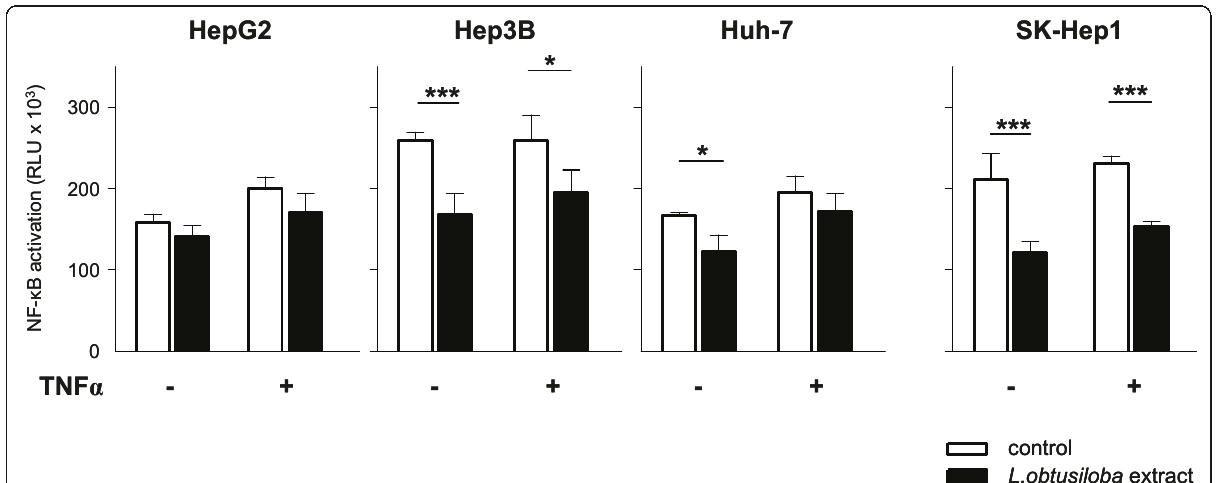
Figure 3 NF- (cid:1) B activity of HCC cell lines in the presence of L.obtusiloba extract . HCC cell lines were transfected with a NF- (cid:1) B/luciferase reporter plasmid and allowed to adhere for 20 h before being treated with 10 μ g/ml TNF a , 100 μ g/ml L.obtusiloba extract or a combination of both. Untreated cells served as negative controls. After additional 24 h, cells were lysed and luciferase activity was determined. Shown are the mean values ± SD of four parallel measurements. *P < 0.05, ***P <